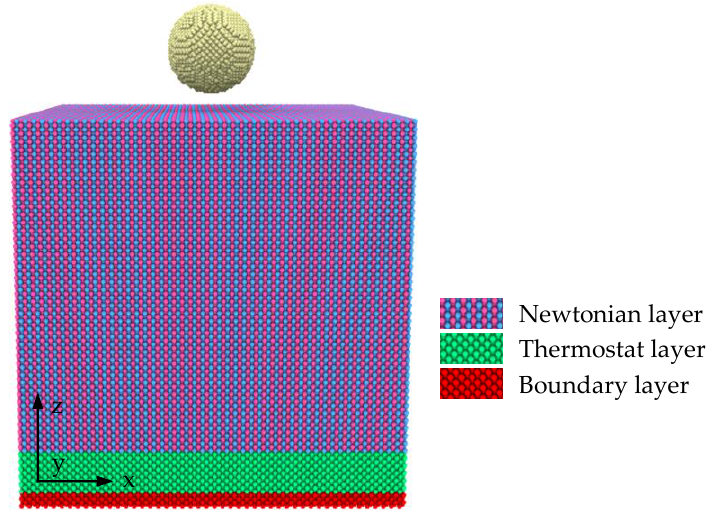
Table 1. Mie 6–12 (Lennard–Jones) potential function parameters used in simulation.